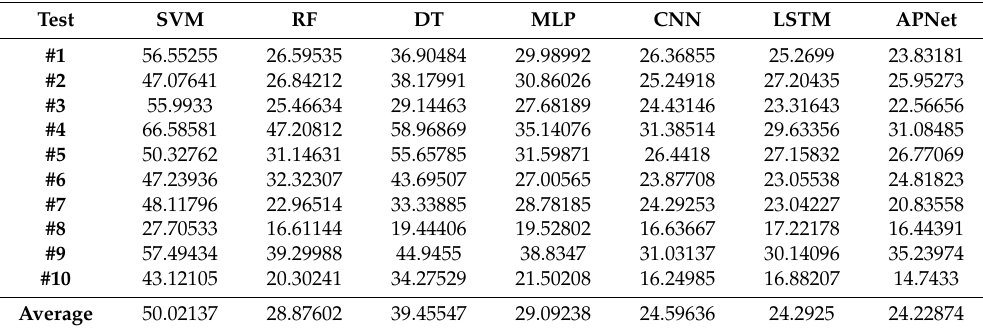
Table 2. The experimental results in terms of Root Mean Square Error (RMSE).